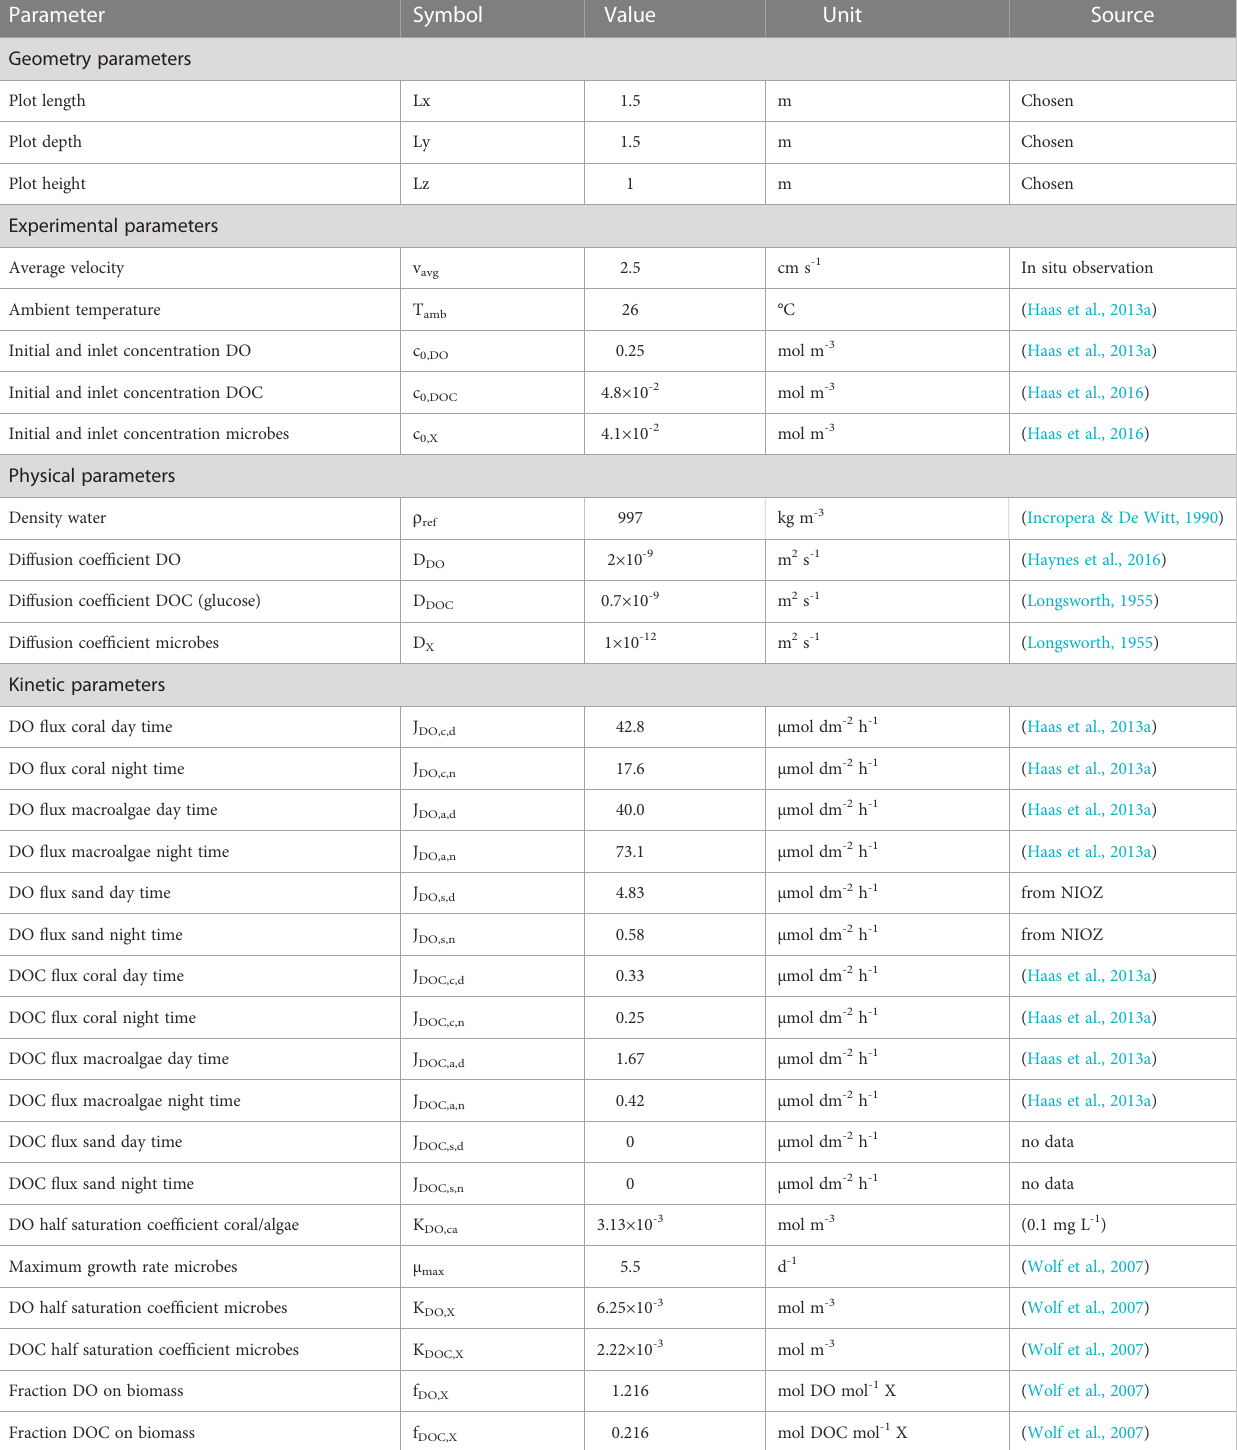
TABLE 1 Model parameters including geometry, experimental conditions and